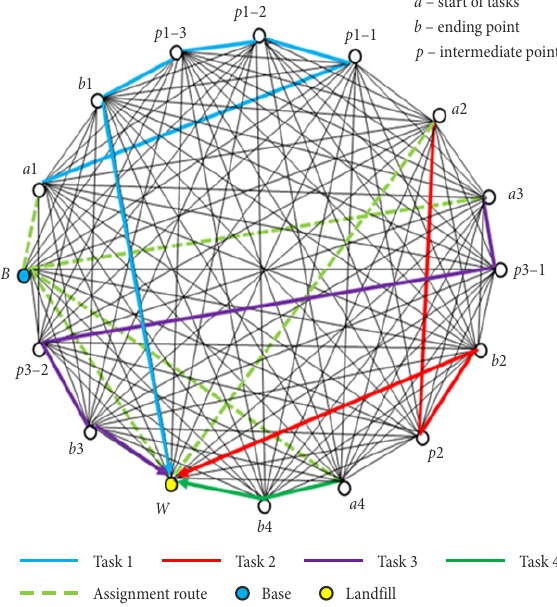
Fig. 1. The graphical interpretation of the assignment problem at municipal services